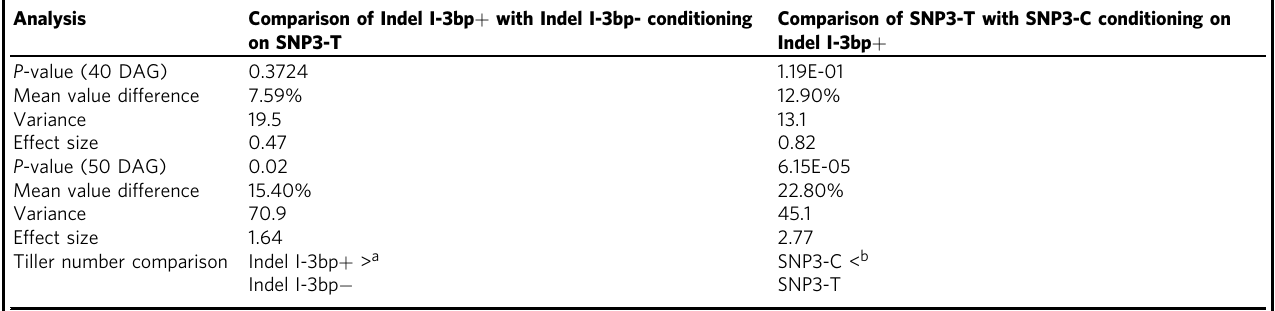
Table 3 Conditional analysis for Indel I and SNP3 in a near-isogenic F 2 population.